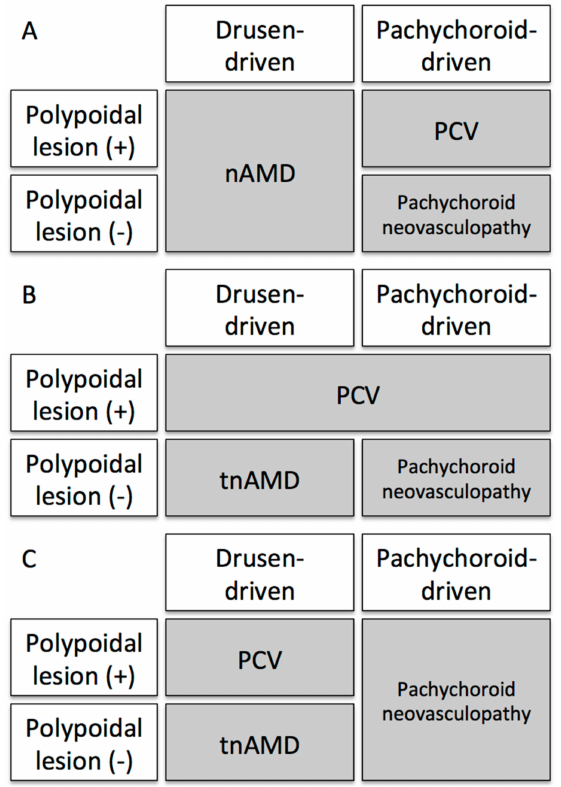
Figure 6. The range of polypoidal choroidal vasculopathy (PCV) and pachychoroid neovasculopathy covers to be discussed. When the usage of PCV is limited to “pachychoroid driven disease with polypoidal lesion”, pachychoroid neovasculopathy should cover the range of “pachychoroid-driven disease with choroidal neovascularization (CNV) but without polypoidal lesion” ( A ). When both “drusen-driven CNV with polypoidal lesion” and “pachychoroid-driven CNV with polypoidal lesion” into PCV, then “pachychoroid neovasculopathy without polypoidal lesion” should be true pachychoroid neovasculopathy and “drusen-driven neovascular AMD without polypoidal lesion” might have to be called “drusen-driven typical neovascular AMD” ( B ). When we apply pachychoroid neovasculopathy regardless of the existence of a polypoidal lesion, “drusen-driven neovascular AMD with polypoidal lesion” might be called PCV ( C